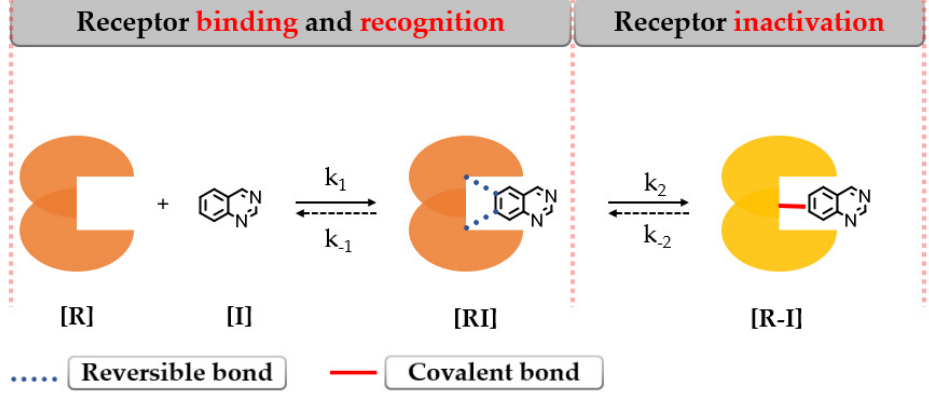
Figure 18. The 2-step formation of a covalent bond between the target [ R ] and inhibitor [ I ] [141].